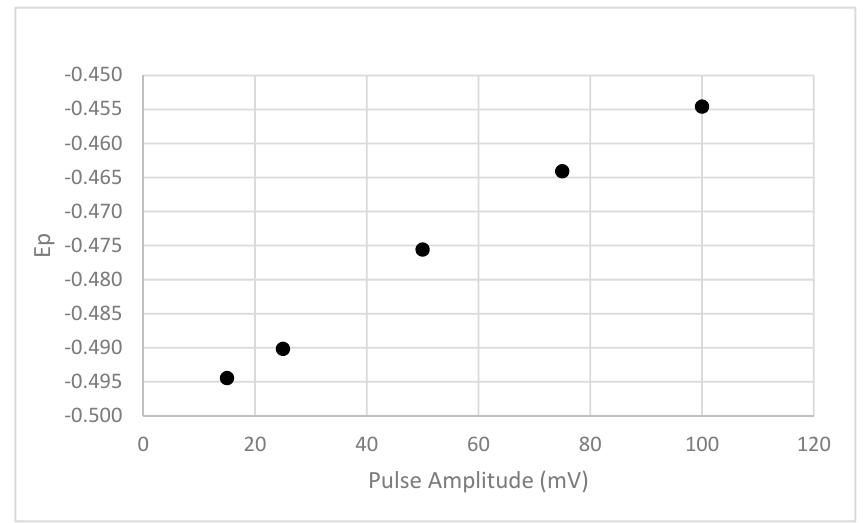
Figure 15. The influence of the DPP pulse amplitude on the Ep value. The results are shown for Pahokee peat humic acid at 100 mg/L and a pH of 8 and in the presence of 1.0-M NaNO 3 . The Pb 2+ concentration was 4.8 uM.